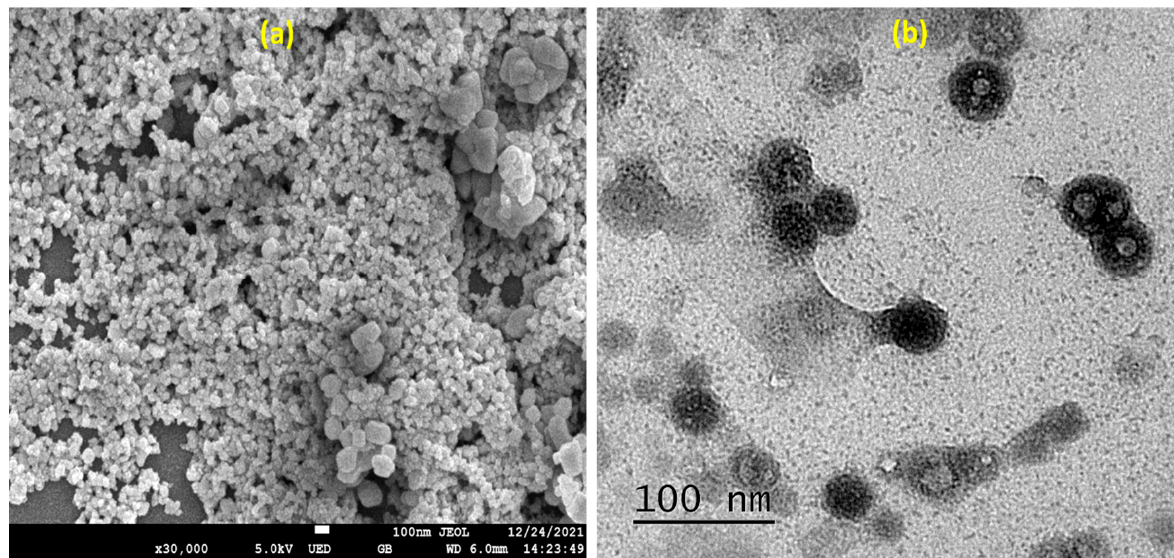
Figure 3. Morphology of Rutin-SNPs ( a ) FE-SEM; ( b ) HRTEM.